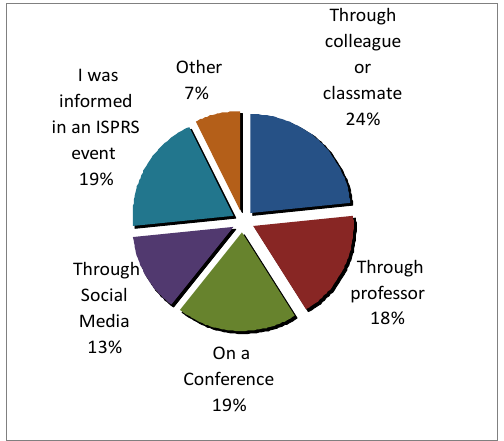
Figure 13. Representation of the results of first question on how members are first acquainted with the SC.